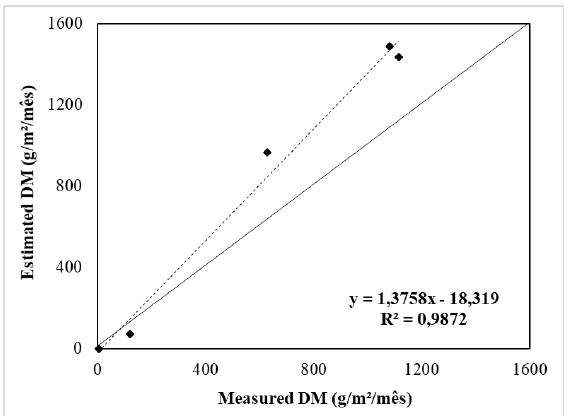
Figura 7. Linear regression between soybeans dry matter (DM), estimated by Montheith's adapted equation (1972), and field- measured Carazinho/RS,